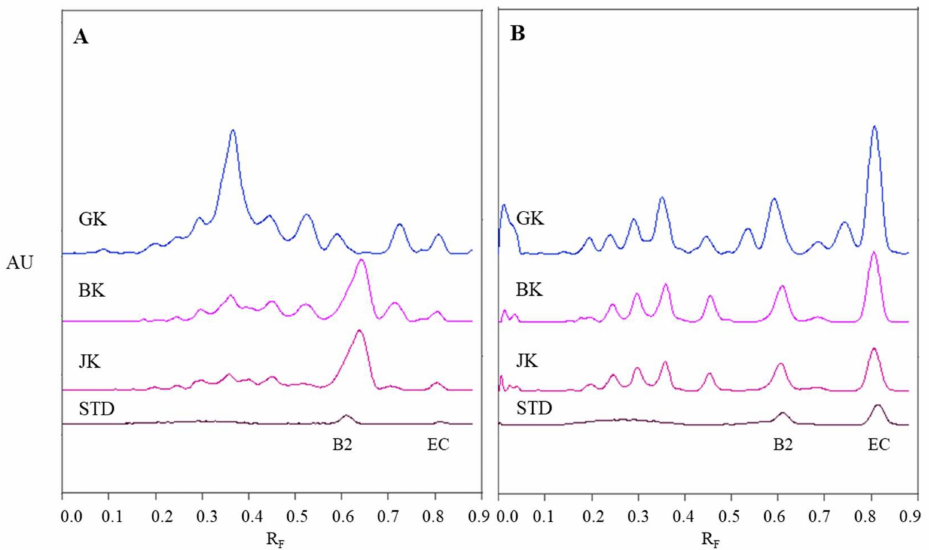
Figure 5. Densitograms of STSs (1 µ L, 50 mg / mL) from leaves of Japanese ( JK ), giant ( GK ) and Bohemian ( BK ) knotweed and standard solutions ( STD , 40 ng) of ( − )-epicatechin ( EC ) and procyanidin B2 ( B2 ) scanned in absorption / reflectance mode at 280 nm before derivatization ( A ) and at 655 nm after derivatizationwithDMACAreagent( B ).HPTLCsilicagelplatewasdevelopedwithtoluene-acetone-formic acid (3:6:1, v / v